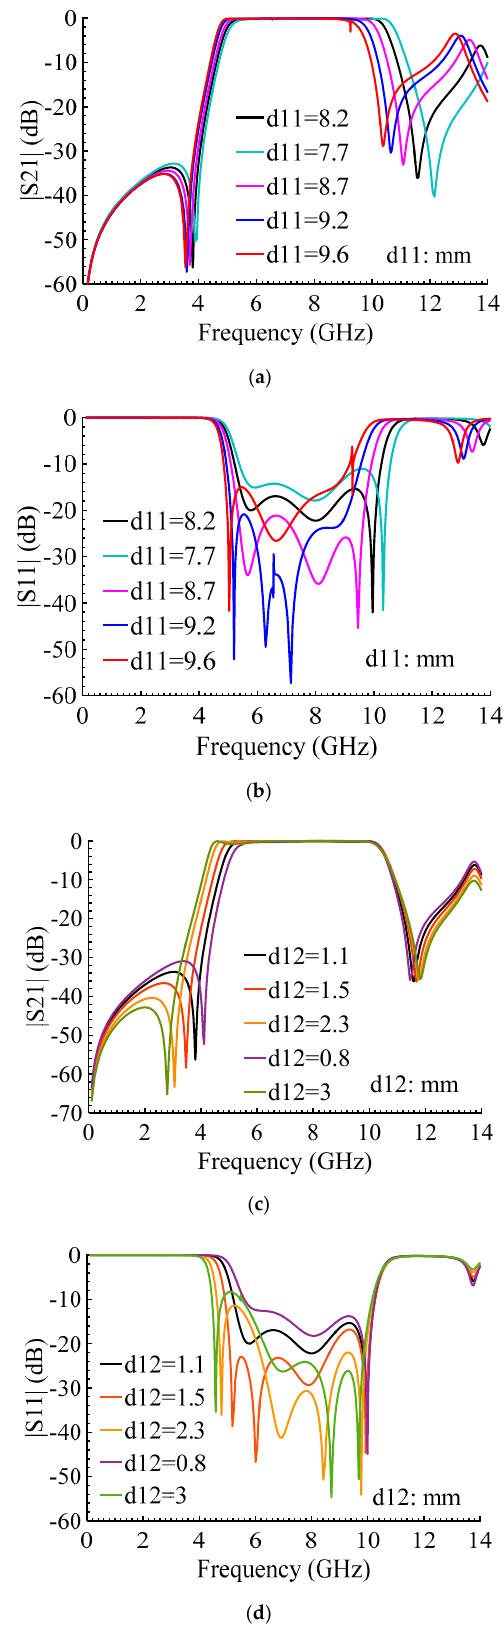
Figure 4. Passband tunability of the single-band BPF (Figure 2a): ( a ) |S21| variations versus d11, ( b ) |S11| variations versus d11, ( c ) |S21| variations versus d12, ( d ) |S11| variations versus d12.